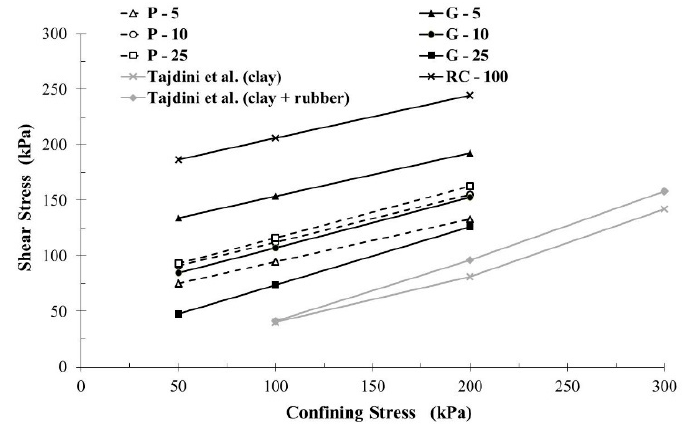
Figure 7. Shear stress versus confining stress for (RCR) mixtures and for the clay and clay-crumb mixtures (based on this study and Tajdini et al.’s tests [31]).